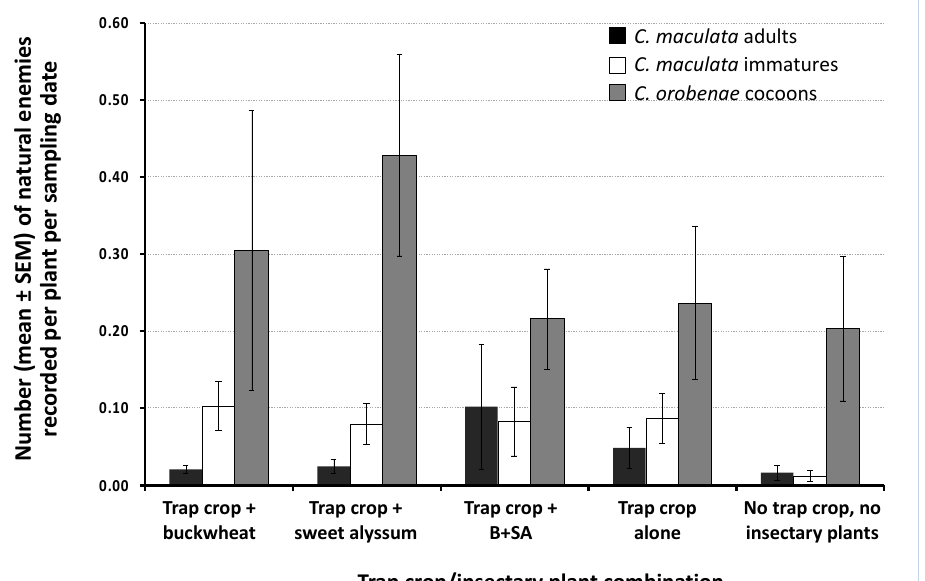
Figure 7. Natural enemy cash crop abundance on a per-plant basis. B+SA= buckwheat + sweet alyssum. There were no significant differences in their abundance on cabbage plants in response to insectary plant treatment according to ANOVAS and Fisher-protected LSD tests (P < 0.05).